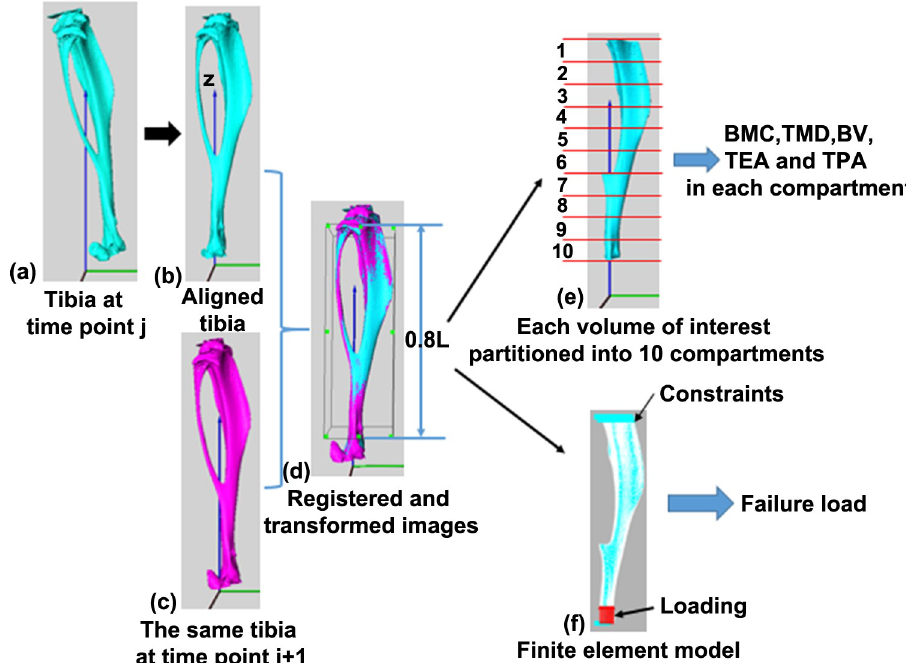
Fig 1. Schematic representation of the calculation of the structural, densitometric and mechanical properties of the tibia. (a-d) Rigid registration of the mouse tibiae using a stepwise approach; (e) quantification of the structural (BV, TEA and TPA) and densitometric (BMC and TMD) properties of the tibia; (f) calculation of the mechanical (failure load) properties of the tibia.